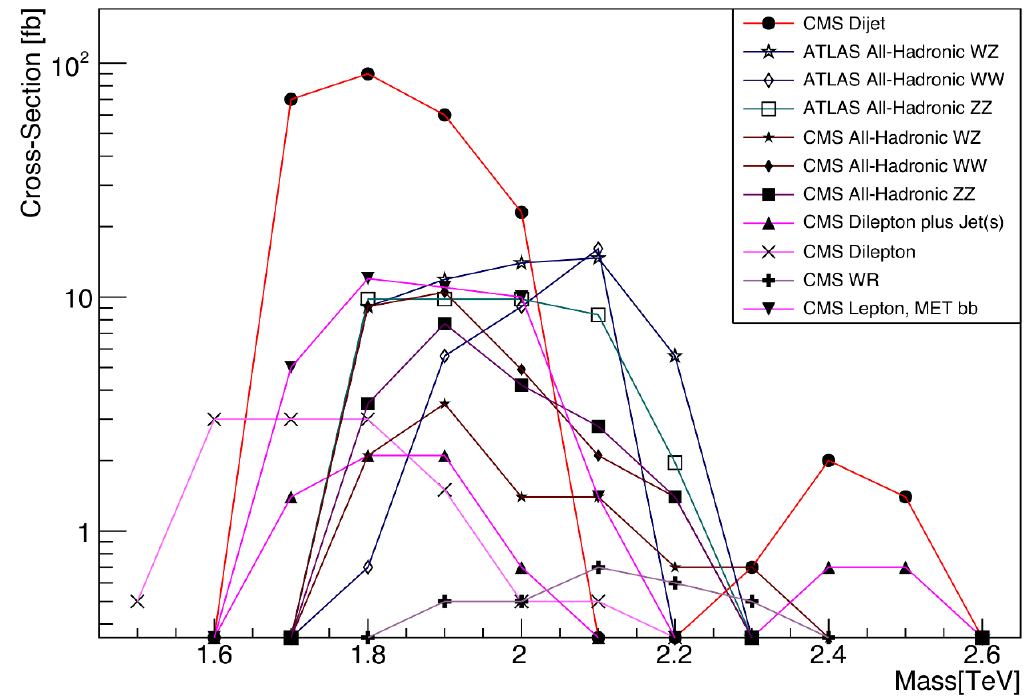
Figure 3 . Cross sections for ATLAS and CMS Run 1 diboson excesses estimated from signi(cid:12)cances greater than 1.5 (cid:27) ; from ref. [59]. The CMS dijet with an estimated cross section of (cid:24) 100 fb (cid:0) 1 was not seen in Run 2